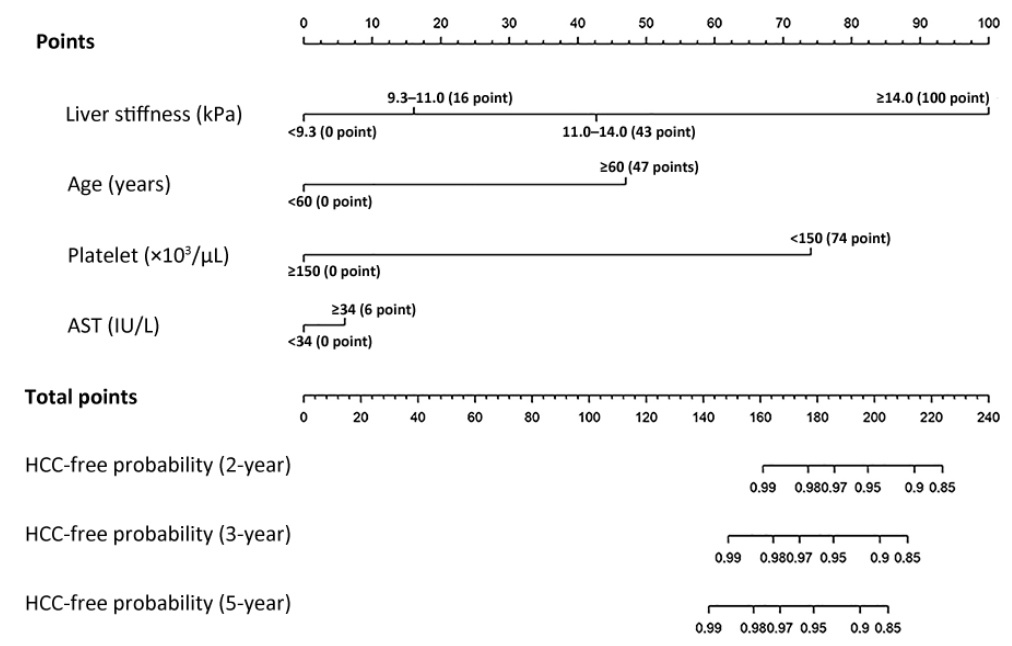
Figure 2. A nomogram of the risk prediction model for HCC development in patients with non-alcoholic fatty liver disease. HCC, hepatocellular carcinoma; AST, aspartate aminotransferase.